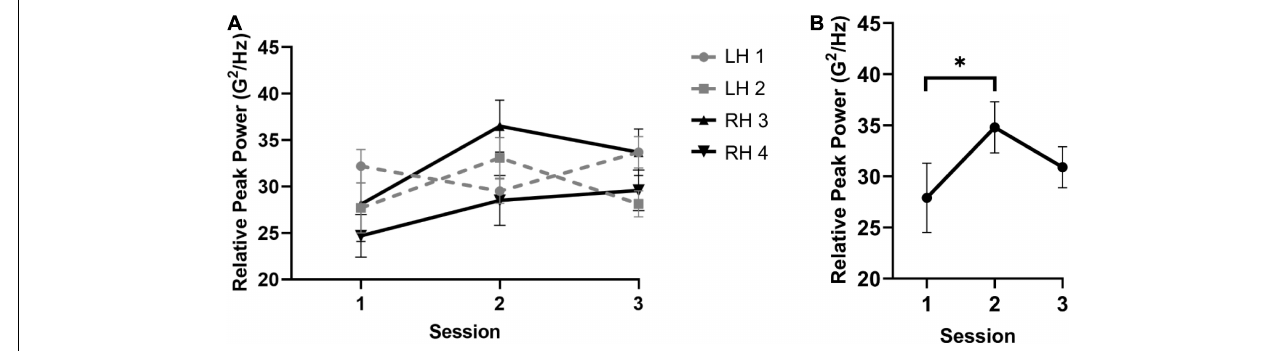
FIGURE 2 | Results for the frequency-based analysis of mallet movements. The overall pattern of effects for peak power and the significant mallet × session interaction is shown in panels (A,B) , respectively. The analysis revealed that relative peak power increased specifically for the thumb mallets between sessions 1 and 2. *indicates significance at the Bonferroni corrected alpha threshold.